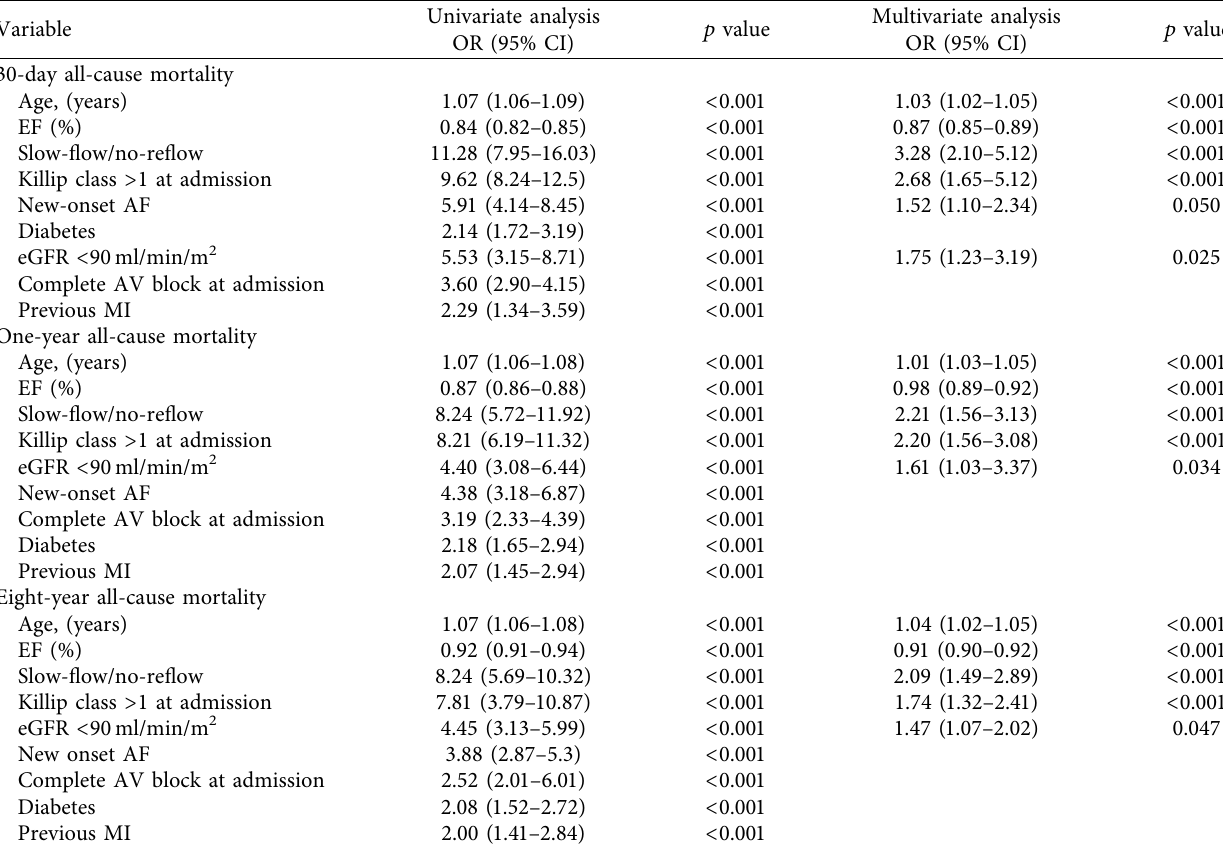
Table 4: Univariate and multivariate Cox regression analysis showing independent predictors for short- and long-term (one-year and eight-year) all-cause